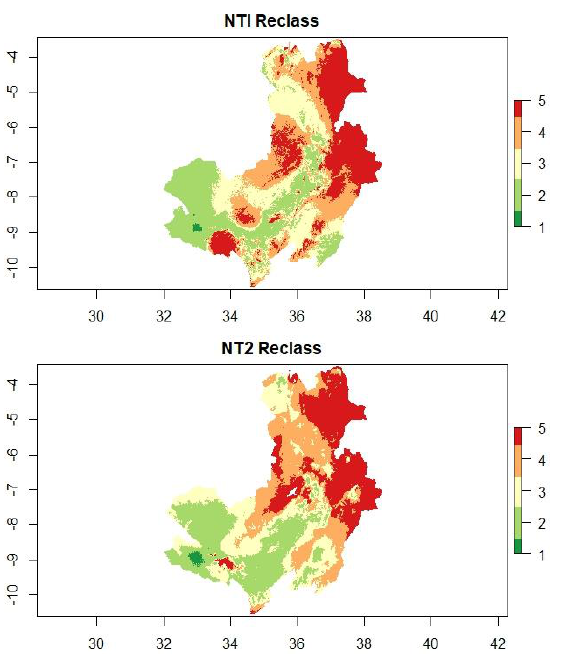
Figure 3. Reclassified suitability categories derived from